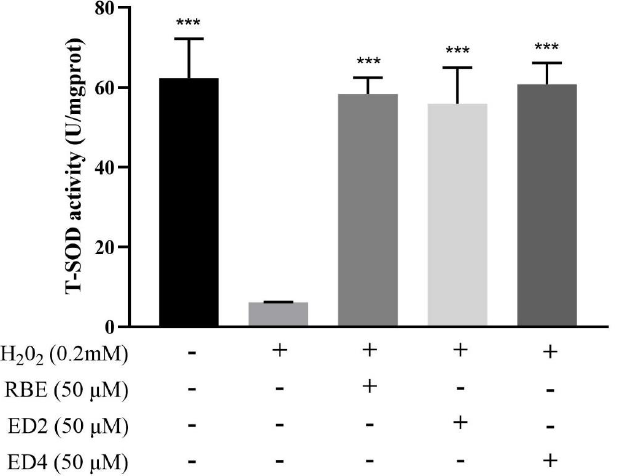
Figure 4. Effects of 50 µM of RBEs, ED2, and ED4 on SOD activity in H 2 O 2 -treated HepG2 cells. Data were obtained from 3 – 5 independent experiments and are presented as mean ± SEM. The annotation *** indicates a p -value < 0.001 versus H 2 O 2 -treated